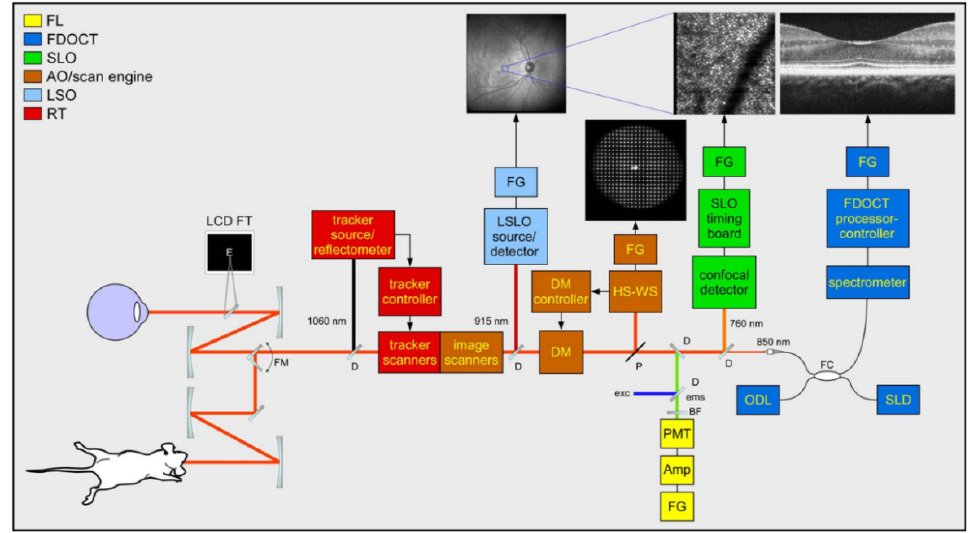
Figure 9. Simplified schematic diagram of a multimodal retinal imaging system combining AO-SLO and AO-OCT. FM, flip mount; D, dichroic beamsplitter; BF, barrier filter; FG, framegrabber; FC, fiber coupler; ODL, optical delay line; SLD, superluminescent diode (Reprinted with permission from Ref. [143]. Copyright 2012, Optical Society of America).